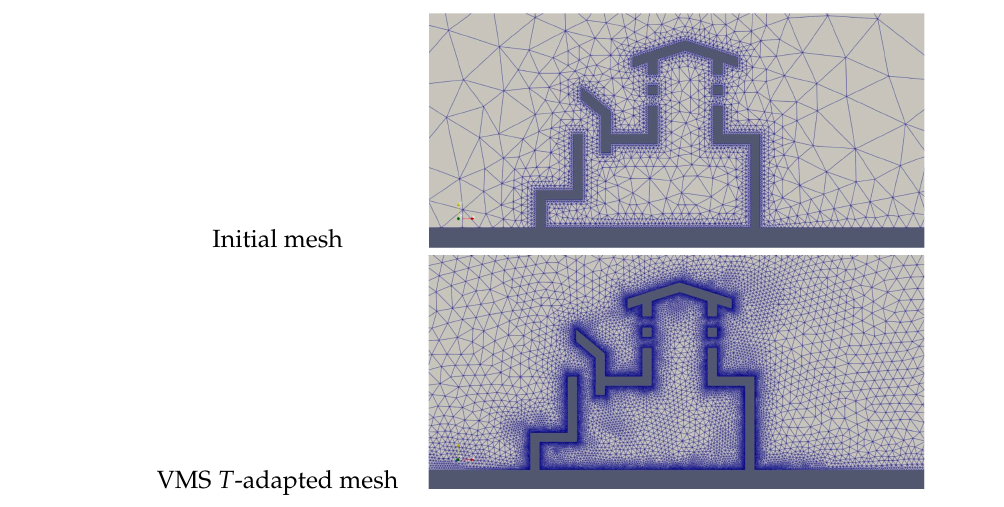
Figure 16. Wind tower 1. Zoom of initial and adapted mesh around the tower.